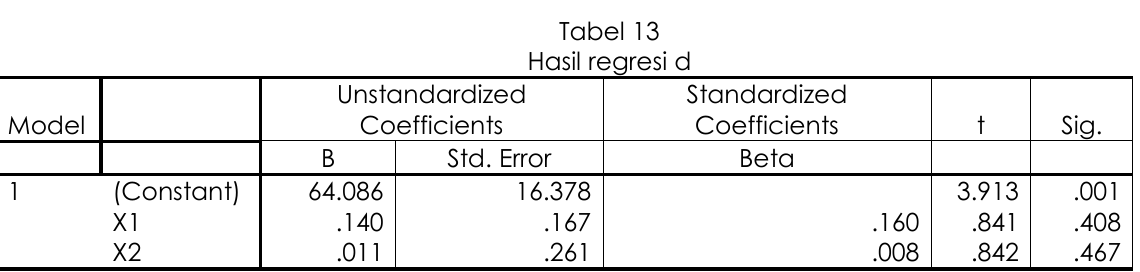
Dari table 12 menunjukkan bahwa secara simultan pengaruh Etika Kerja Islam dan Etika Bisnis terhadap Komitmen Profesional menunjukkan pengaruh sebesar 0,026 pengaruh ini